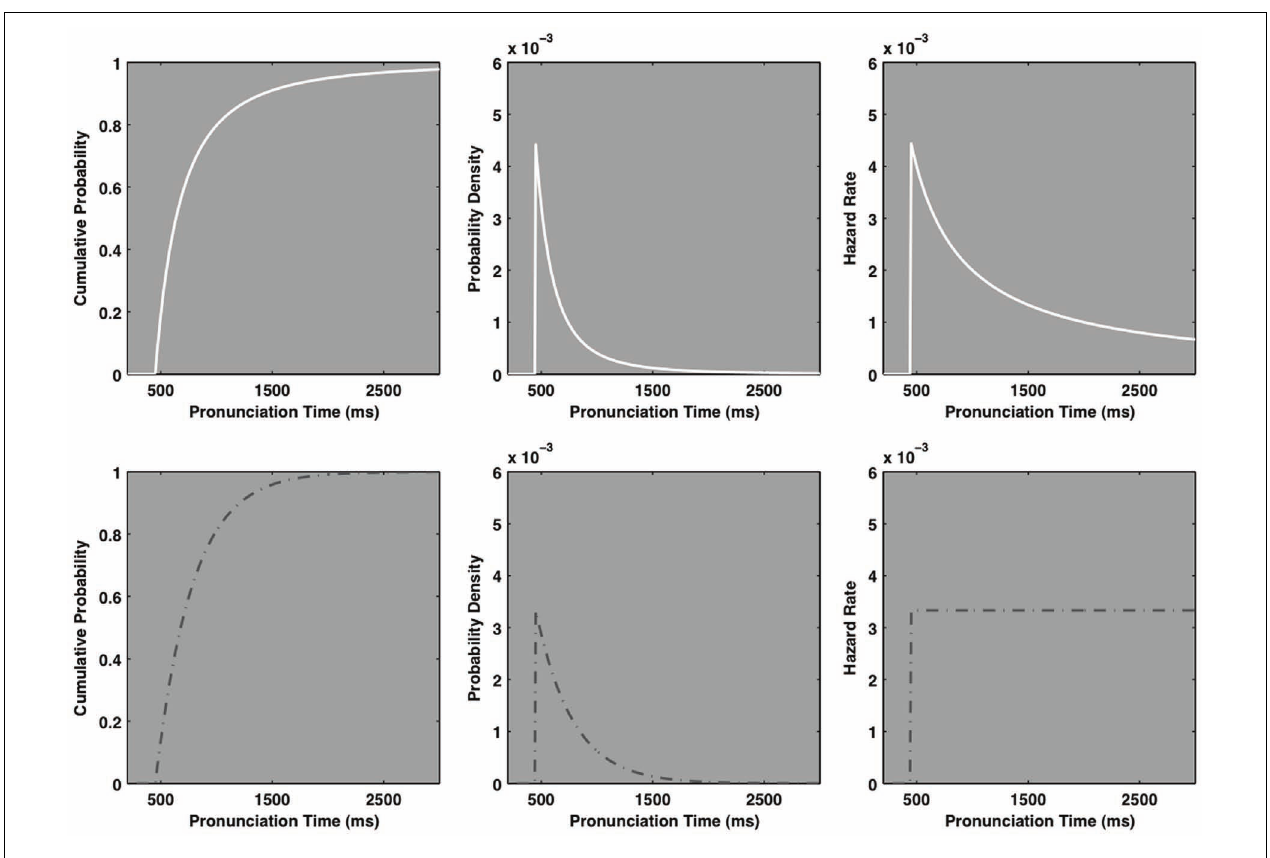
similar, but the hazard functions are qualitatively distinct.The power law hazard, itself, decays as a power law. By contrast, the exponential hazard is constant.The BIC mean squared integrated error analysis capitalizes on the qualitative and quantitative difference in the hazard